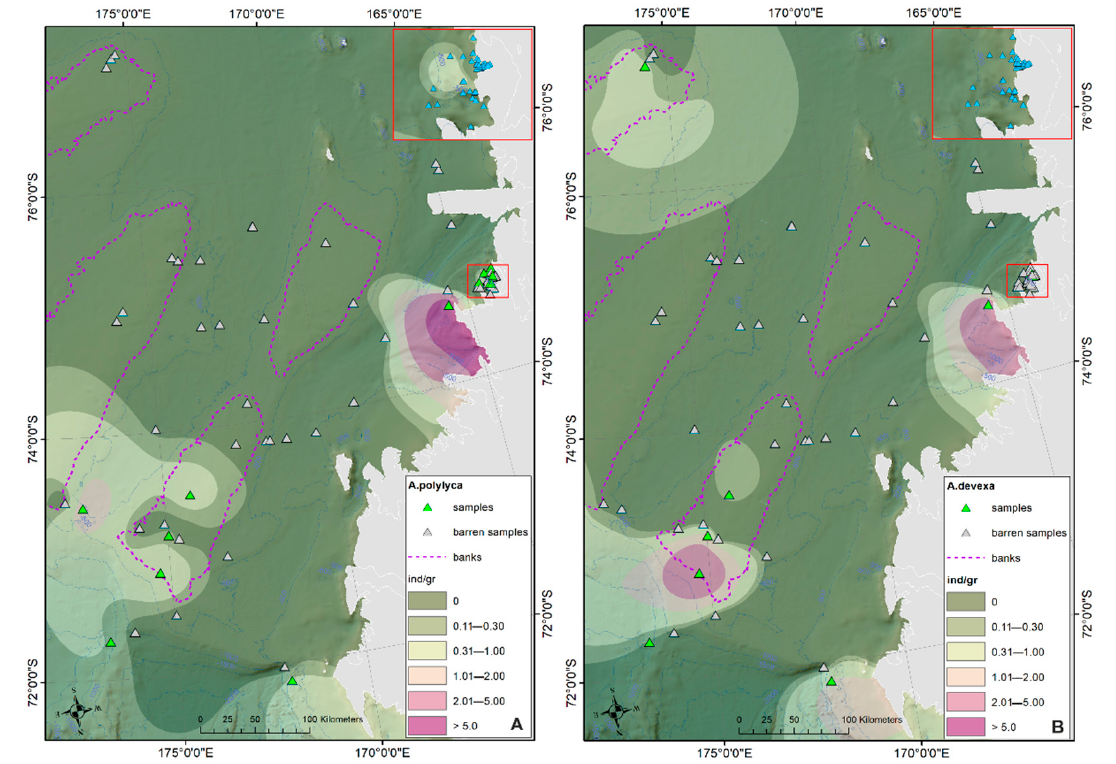
Figure 9. GIS Predictive A. polylyca ( A ) and A. devexa ( B ) distribution maps interpolated in GIS ap- plying the spline method using barriers. Isobaths every 500 m.